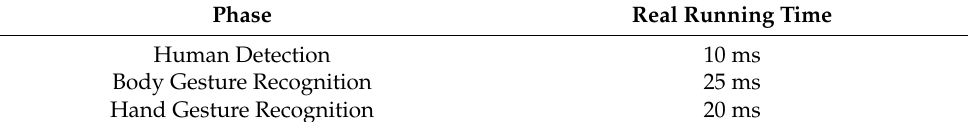
Table 6. Real running time of the proposed Jetson AGX Xavier GPU-based UAV platform.